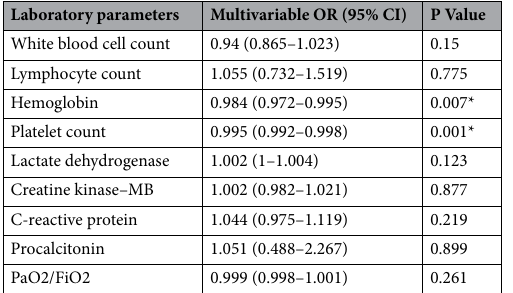
Table 3. Multivariate analysis of AST/ALT ≥ 1.38. *A two-tailed P value less than 0.05 was considered statistically